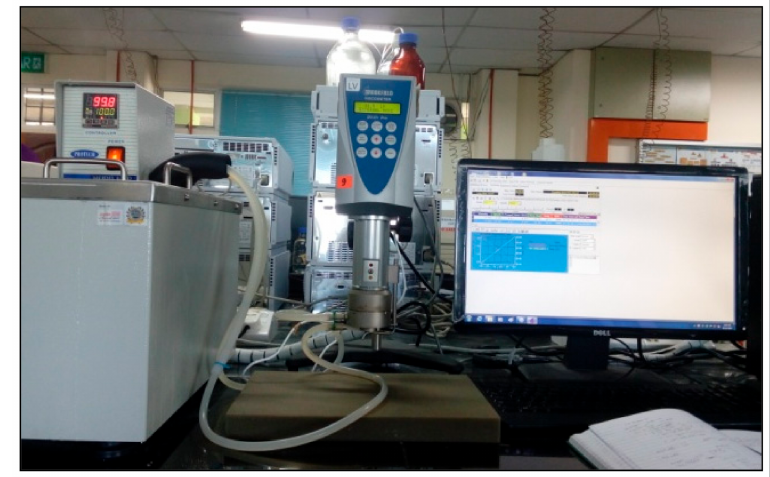
Figure 15. Brookfield DV-II + Pro Automated viscometer with CP-41